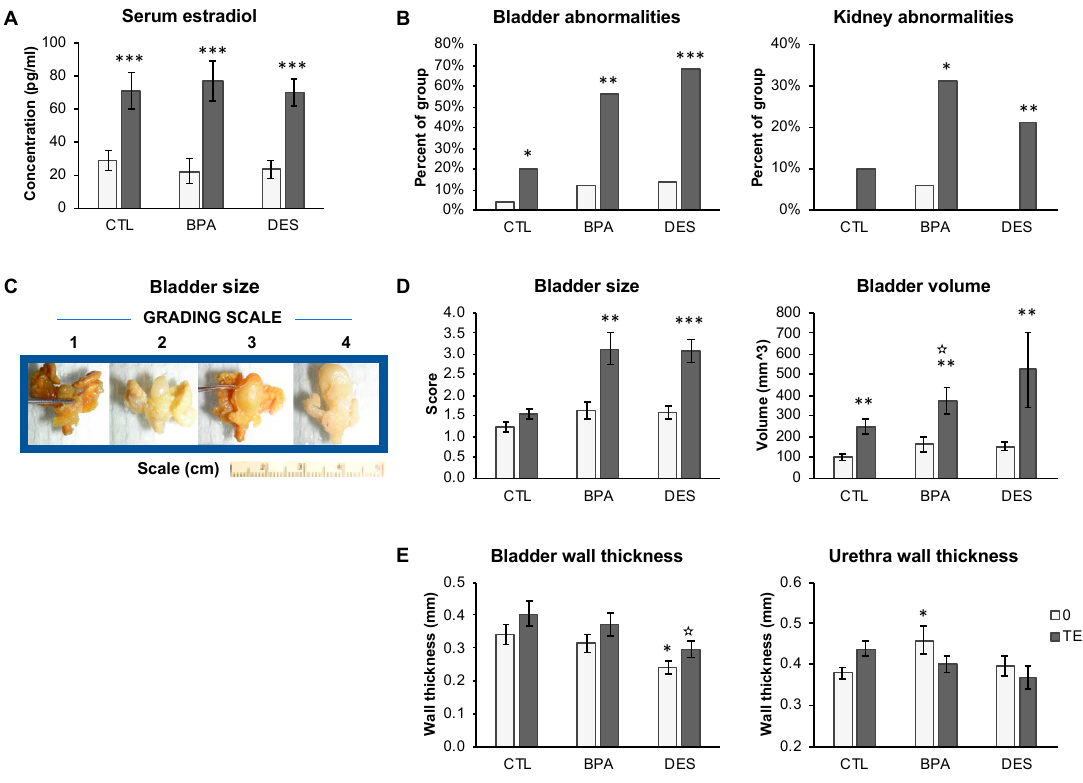
Figure 1. Serum estradiol concentrations and bladder, kidney, and urethra metrics in control (CTL-), BPA-, or DES-treated mice, without (0, light bars) and with (TE2, dark bars) adult treatment. ( A ) Serum estradiol concentrations and ( B ) incidence of bladder and kidney abnormalities observed at the time of necropsy. ( C ) Examples of bladder size using the observational grading scale. ( D ) Bladder size based on observational grading (left) or on volume calculated from external dimensions (right) in fixed tissues. ( E ) CT measurements of bladder wall thickness and post-prostatic urethra wall thickness in fixed tissues. Values are mean ± SEM. * P < 0.05, ** P < 0.01, *** P < 0.001 vs. CTL-0; ✫ P < 0.05 vs. CTL-TE2.